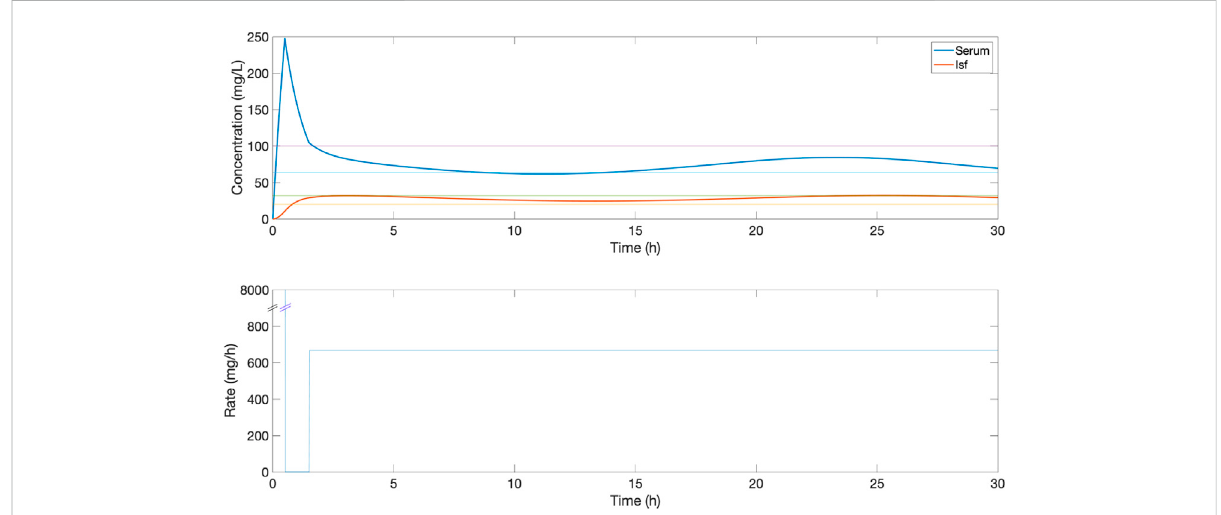
FIGURE 4 AnexampleoftheserumandISFconcentration(mg/L)ofpiperacillinandcorrespondingIVrate(mg/h)foran insilico patientdosedbyprotocol 2, a standard clinical dosing protocol where a loading dose of 4,000 mg is followed by a fi xed continuous rate of 4,000 mg/6 h. In this patient, this continuous dose leads to serum concentrations above the 32 – 64 mg/L target evaluation range.